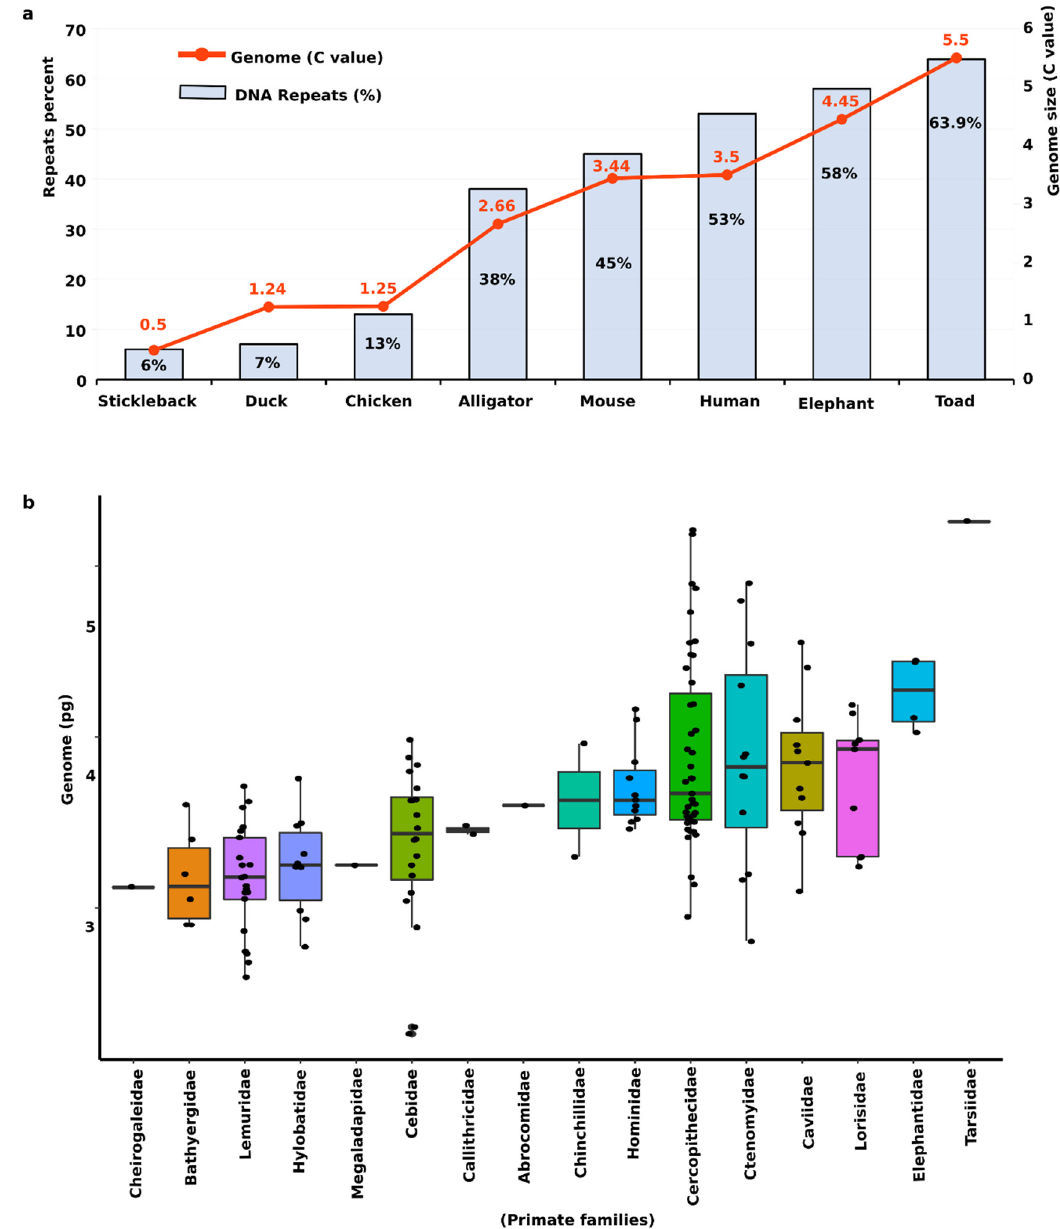
Figure 1. Overview of repeat contents in vertebrates and primate genome size variation. ( a ) Relationship of genome size (C value; red line) with repeat contents (blue bars) in representative vertebrate organisms. ( b ) Boxplot of the distribution and variability of genome size among primate families. Each dot represents a primate species. Note: Data are sourced from the Animal Genome Size Database (http://www.genomesize.com/) [14] and graphics were created in R.